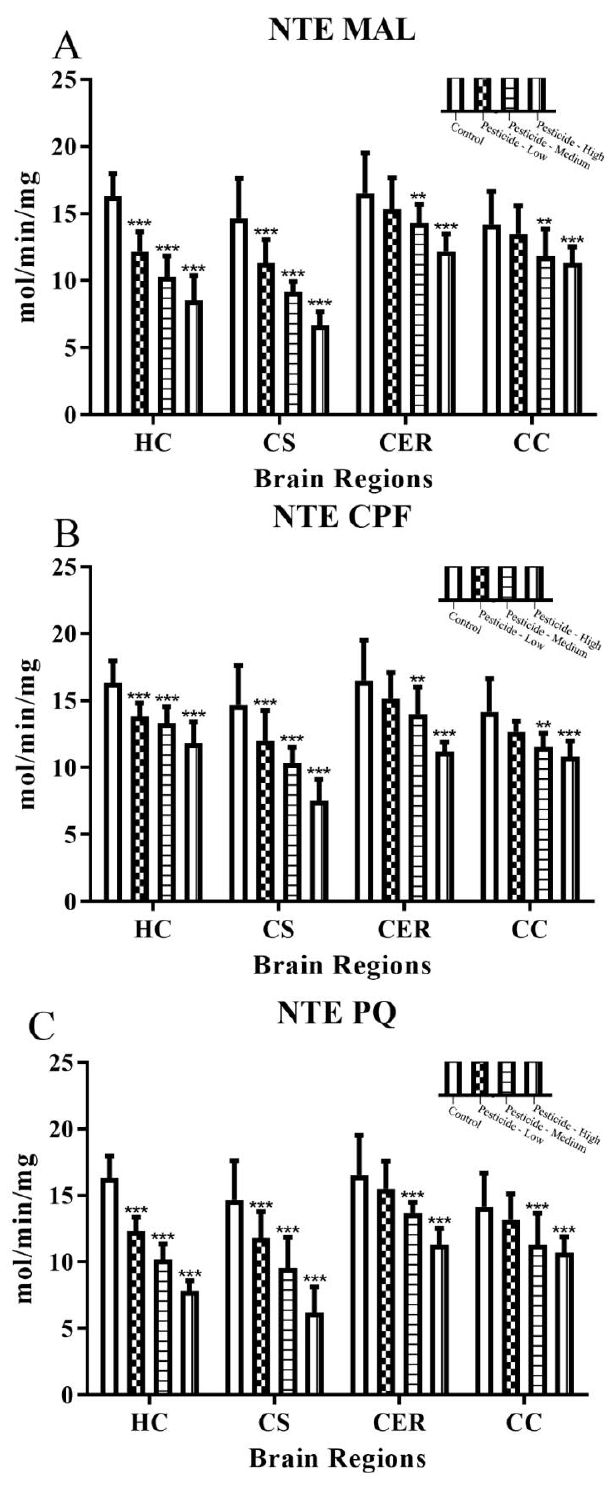
Figure 2. Pesticide-induced inhibition of brain NTE activity. Rats were dosed with malathion (MAL) ( A ); chlorpyrifos (CPF) ( B ); or paraquat (PQ) ( C ); at low, medium, or high dosages and the level of neuropathy target esterase (NTE) activity quantified within the hippocampus (HC), corpus striatum (CS), cerebellum (CER), and cerebral cortex (CC). Histograms are representative of mean values with SDs, with significant changes marked with asterisks, according to ** p < 0.01, and *** p <